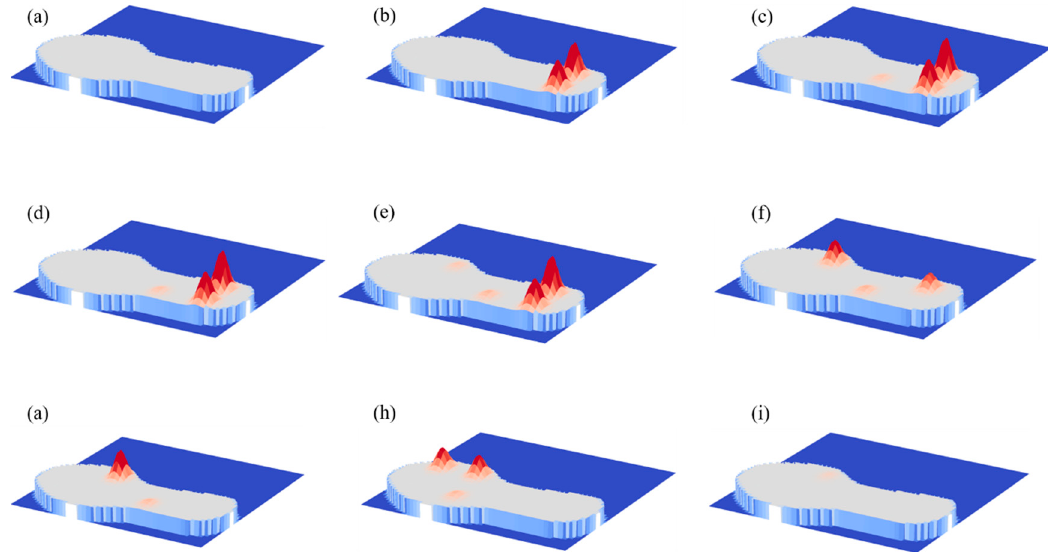
Figure 8. Pressure maps under the foot at different gait phases: ( a ) foot off the ground, ( b – d ) foot starts landing, ( e – f ) foot flat contact, ( g – h ) toe-off ( i ) foot off the ground.